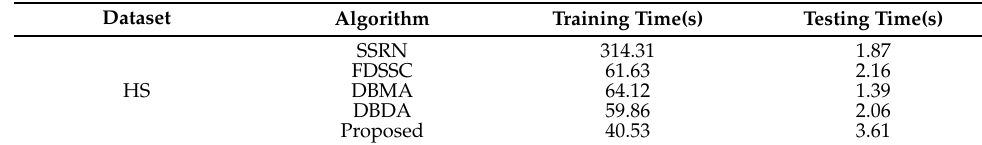
Table 14. Training and testing time consumption for the HS dataset.